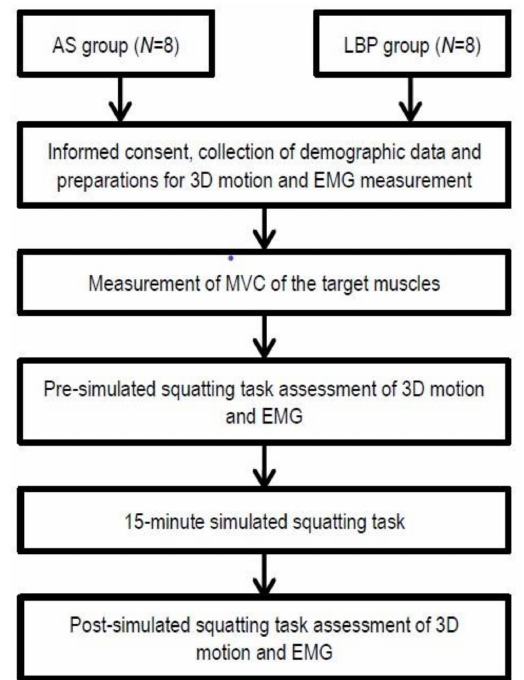
Figure 1. Experimental procedures. Notes: LBP: low back pain. AS: asymptomatic; MVC: maximal voluntary contraction; EMG: